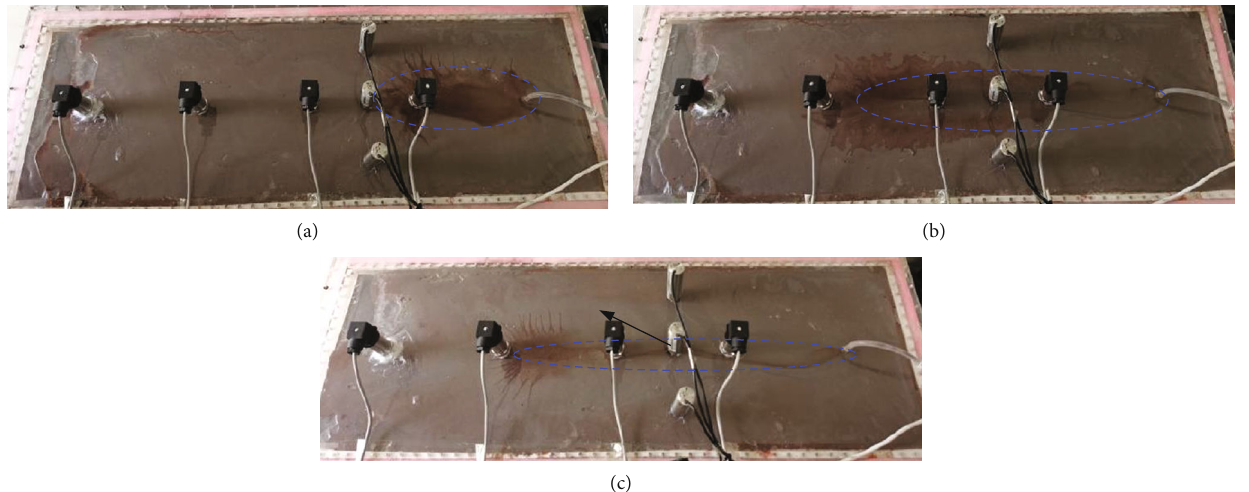
Figure 10: Evolution of slurry fl ow channel. (a) 2730 s, (b) 3030 s, and (c)